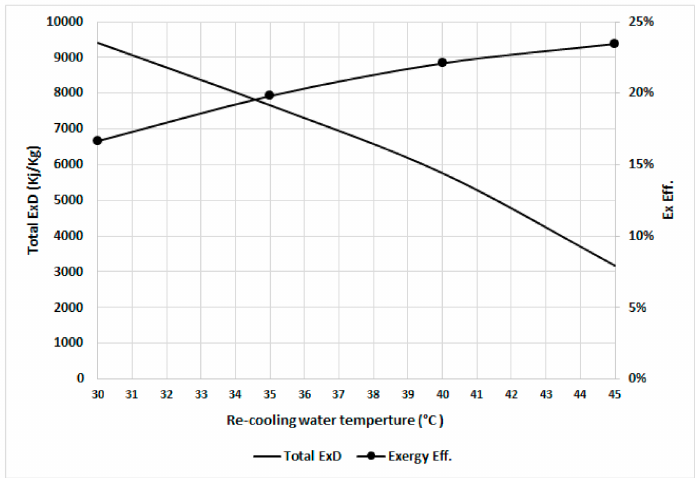
Figure 9. Total exergy destruction and exergetic efficiency in the chiller at various recooling-water